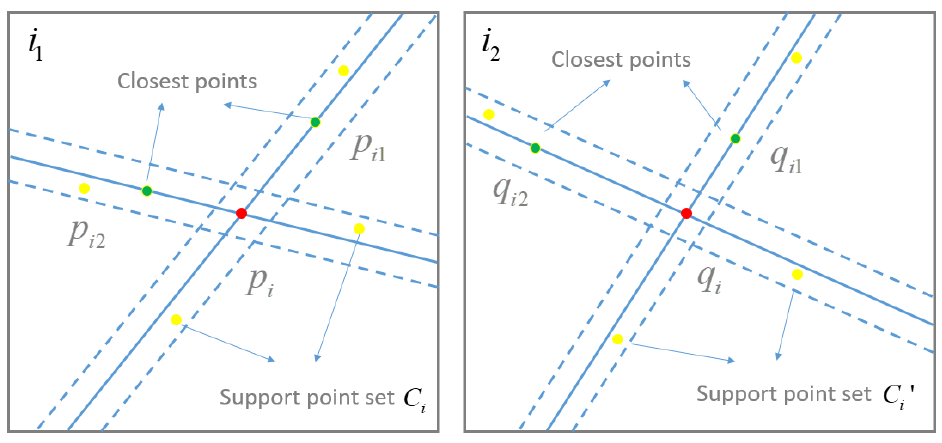
Figure 2. The illustration of the CAI geometric